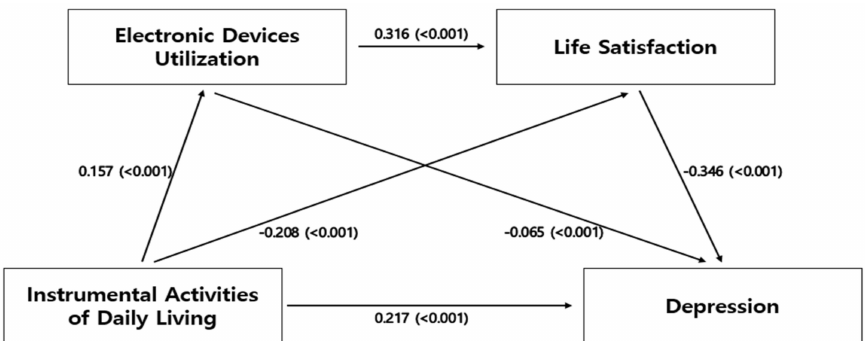
Figure 1. Mediating effect of